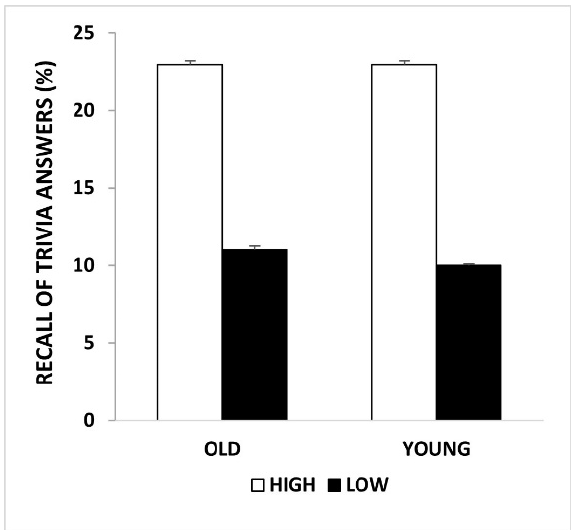
Figure 2. Recall of trivia answers: memory performance for levels of curiosity in young and older adults.